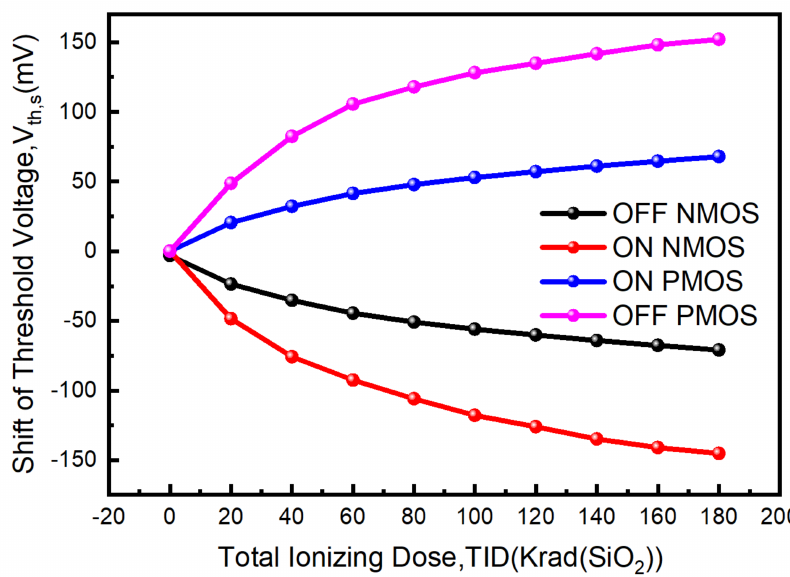
Figure 1. Threshold voltage shift of transistors as a function of ionizing dose and voltage bias.